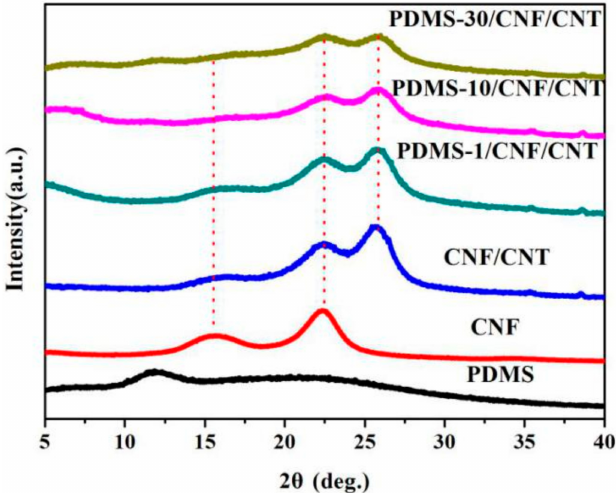
Figure 4. X-ray diffraction profiles of PDMS, CNF, CNF/CNT, and PDMS/CNF/CNT nanocomposite film